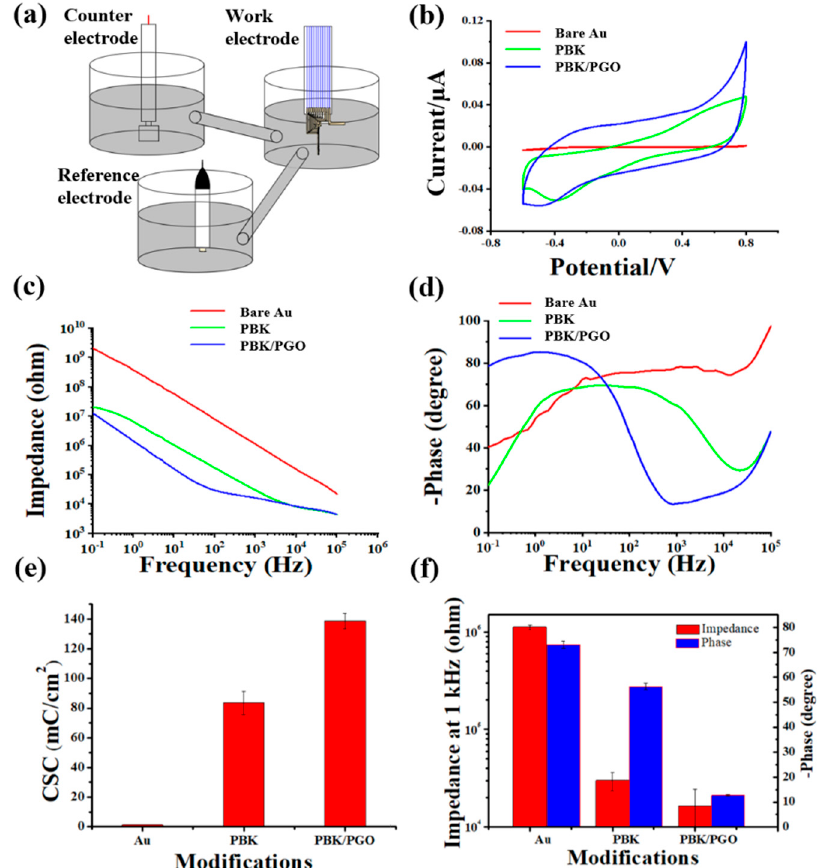
Figure 2. ( a ) Three-electrode system, ( b ) averaged cyclic voltammetry curves, ( c ) electrochemical impedance spectra, and ( d ) phase curves of unmodified, PBK modified, and PBK/PGO modified microelectrodes ( n = 3). ( e ) Histogram of CSC of microelectrode before and after modification. ( f ) Histogram of impedance and phase at 1 kHz of microelectrode before and after modification.